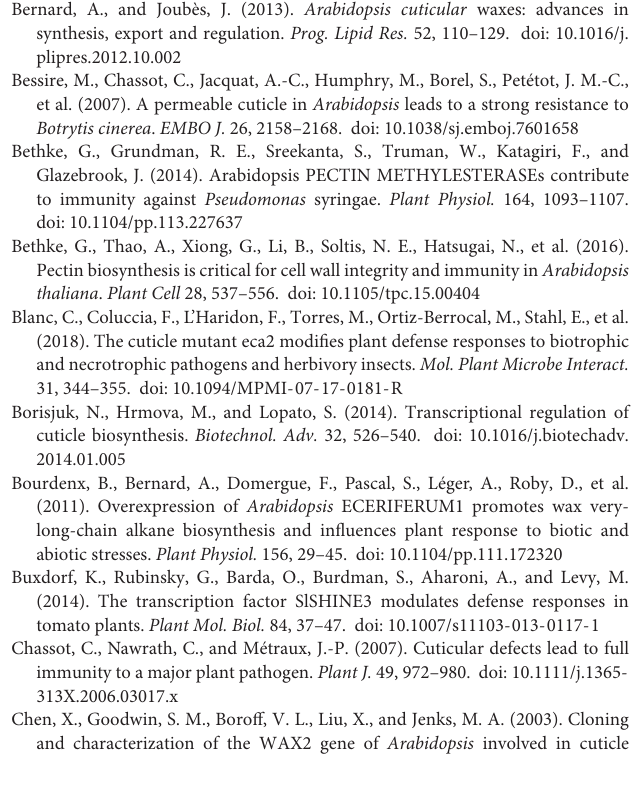
abundant in the infected mutants and WT plants, related to Figure 7